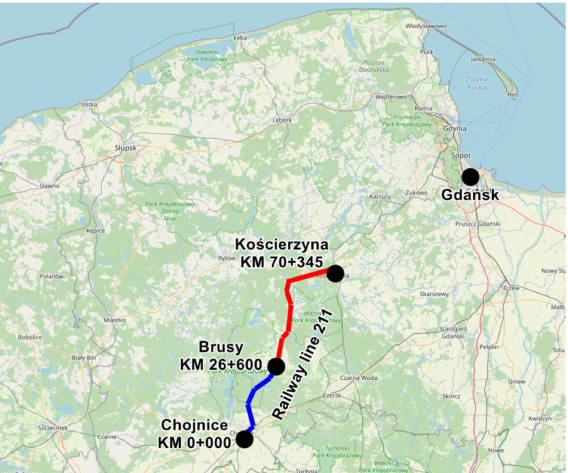
Figure 4. Geographical location of the test segment (marked in